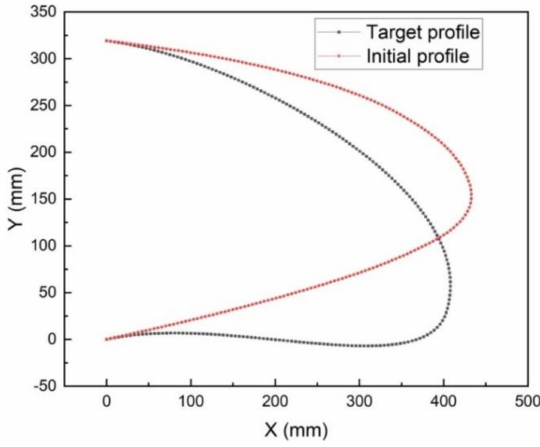
Figure 7. Initial profile and target